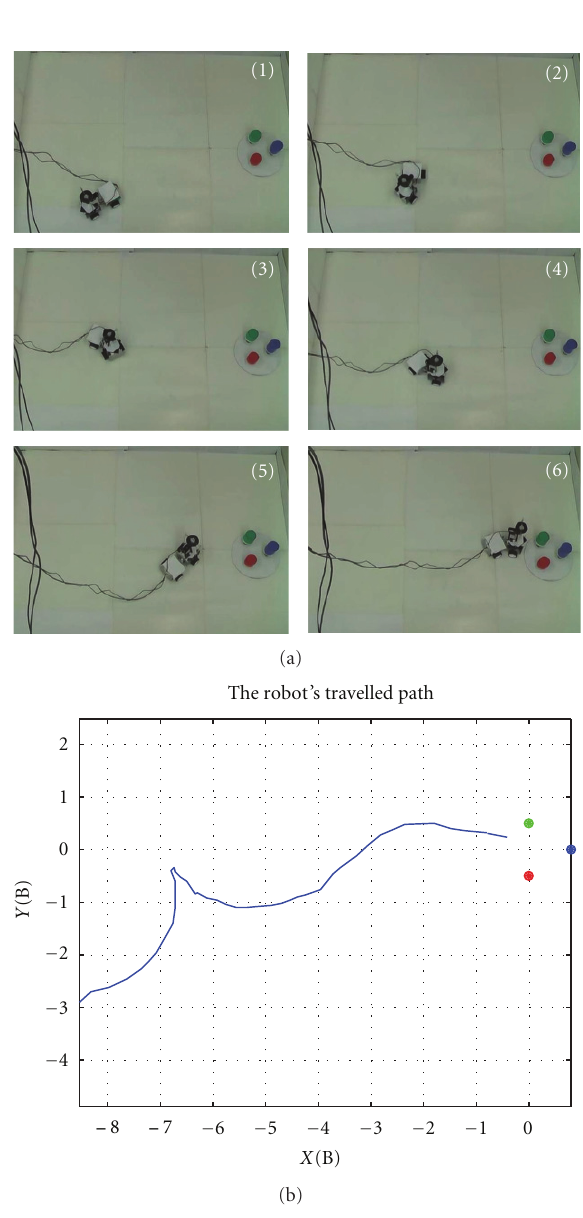
Figure 18: The robot is initially positioned at (8.5 π /8, − π , 0), (a) the snapshots of the experiment, (b) the traveled path of the